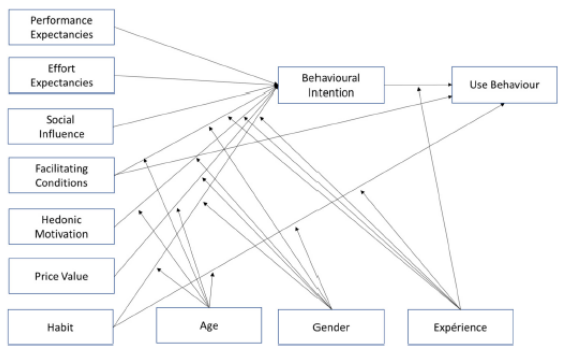
Figure 1. Unified Theory of Acceptance and Use of Technology 2 (UTAUT